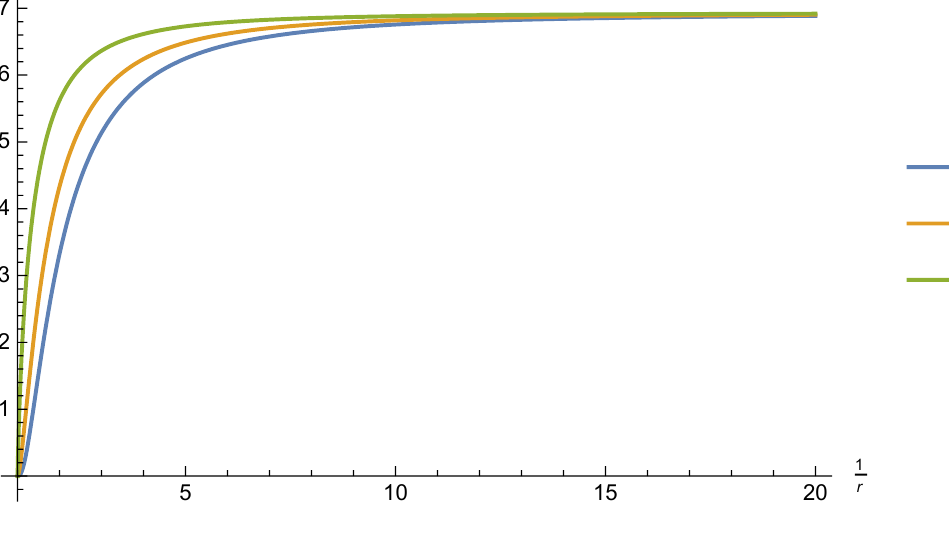
Figure 6 . ∆ S EE as a function of 1 /r = t/y 0 in the zero width limit for scalars under SO(2) T × SO(2) L . Note that the entanglement grows slower as the spin of the field creating the quench increases. the plot for R tyty represents the growth for all components in class 1.